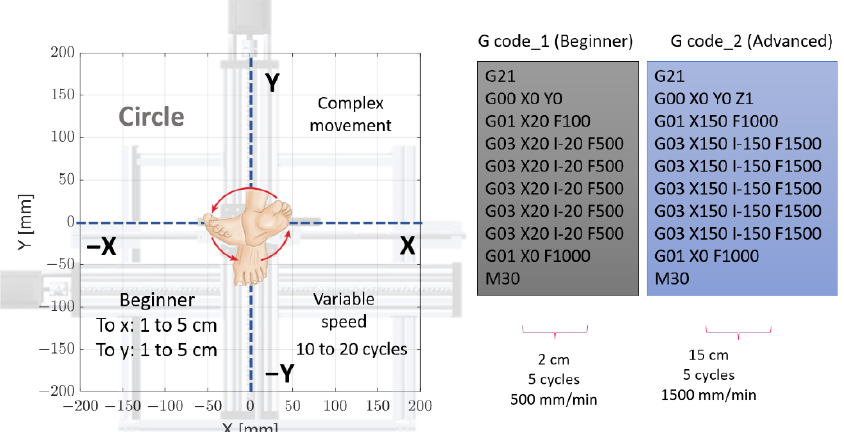
Figure 19. Circular trajectory for ankle rehabilitation movement.